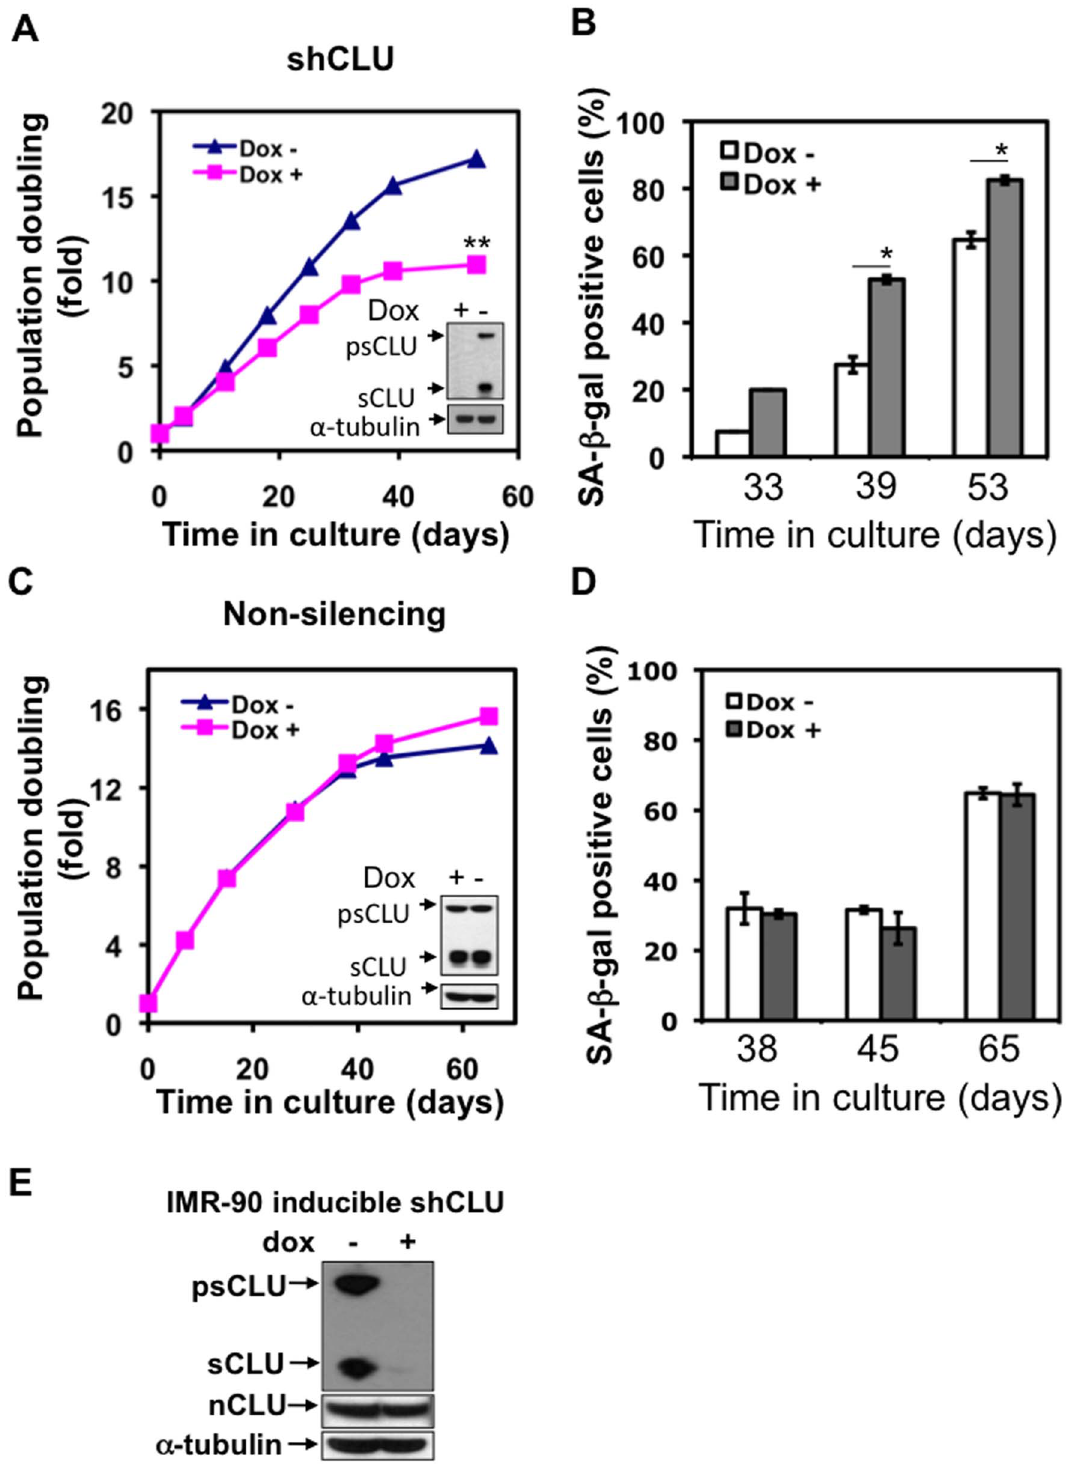
Figure 5. sCLU protects cells from senescence. (A) sCLU was knocked down in an IMR-90 pooled population containing a lentiviral-mediated inducible shRNA-sCLU construct cultured in presence of doxycycline (dox), while expression of sCLU was not affect in the same pooled population in the absence of doxycycline (dox). The population doubling of IMR-90 cells with inducible shRNA-sCLU decreased faster when cultured in the presence of dox compared to in cells cultured without dox. **, p-value of two curves was # 0.01. Experiments were repeated three times, starting from infection of young IMR-90 cells with selection of a pTRIPZ-shCLU-containing pooled population. Similar results were observed in all three experiments and representative results from one experiment are shown. (B) IMR-90 cells with sCLU knockdown had significantly higher %SA- b -gal + cells after being cultured for 33, 39, and 53 days with or without dox. SA- b -gal + staining was performed to identify senescent cells. *, p-value # 0.05. (C) Controls included a pooled IMR-90 cell population contain an inducible shRNA-non-targeted, scrambled shRNA construct were cultured in